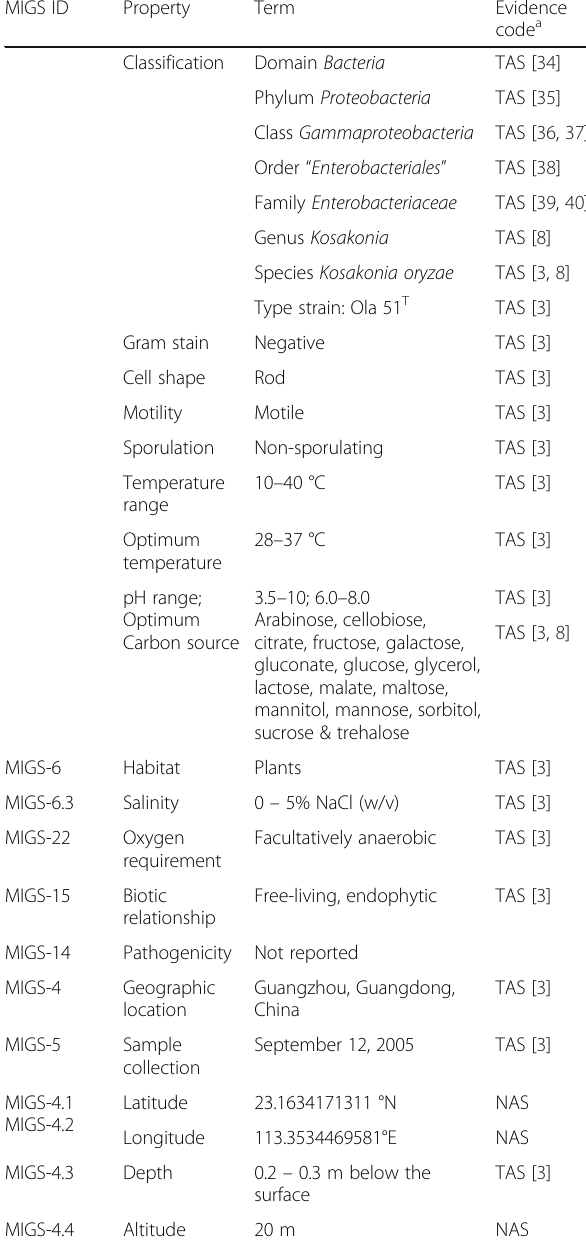
Table 1 Classification and general features of Kosakonia oryzae strain Ola 51 T according to the MIGS recommendations